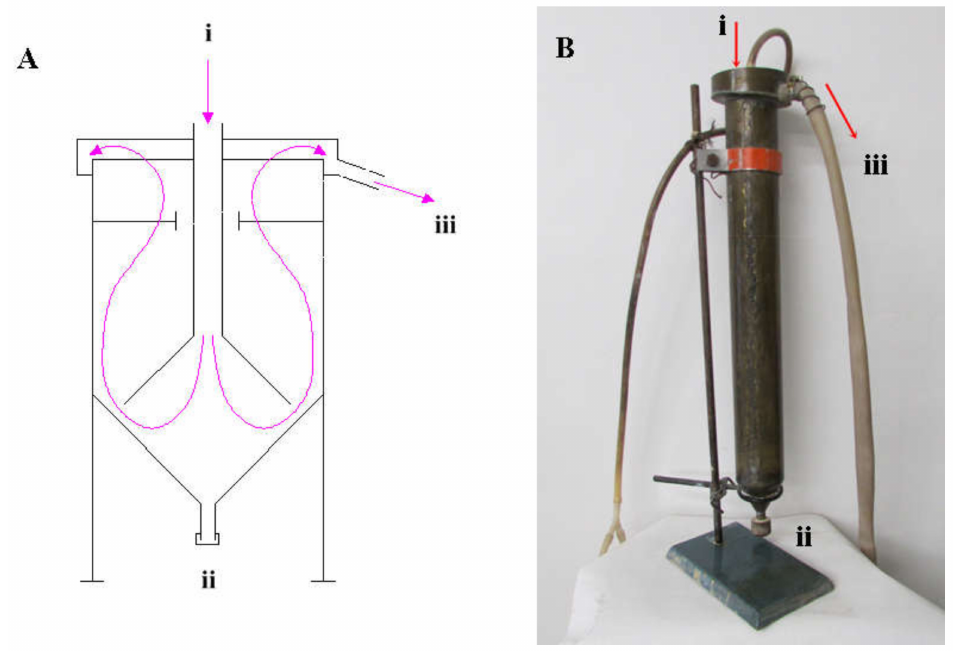
Figure 1. Schulz Column ( A —the basic scheme, B —real Schulz